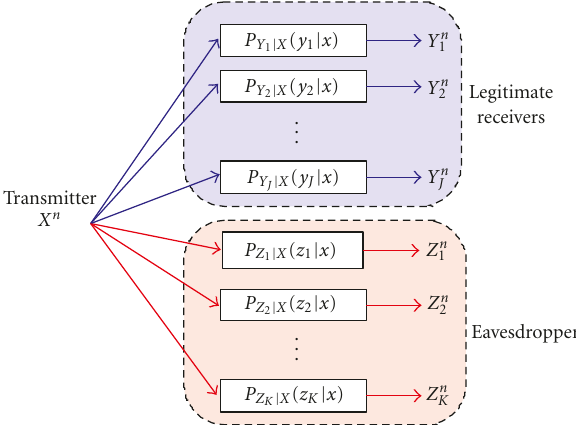
Figure 1: Compound wiretap